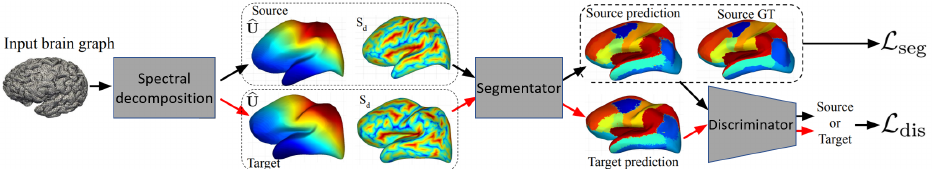
Figure 10. Adversarial graph domain adaptation for segmentation. A cortical brain graph is mapped to a spectral domain. The source and target domain are aligned to a reference template. A GCN segmentator learns to predict a generic cortical parcel label for each domain. Finally, the discriminator classifies the segmentator predictions. Image adapted from